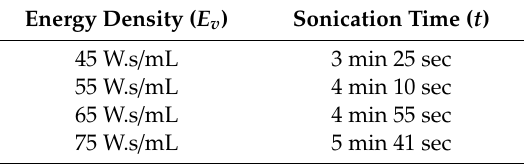
Table 5. Sonication time required to apply the corresponding energy density.